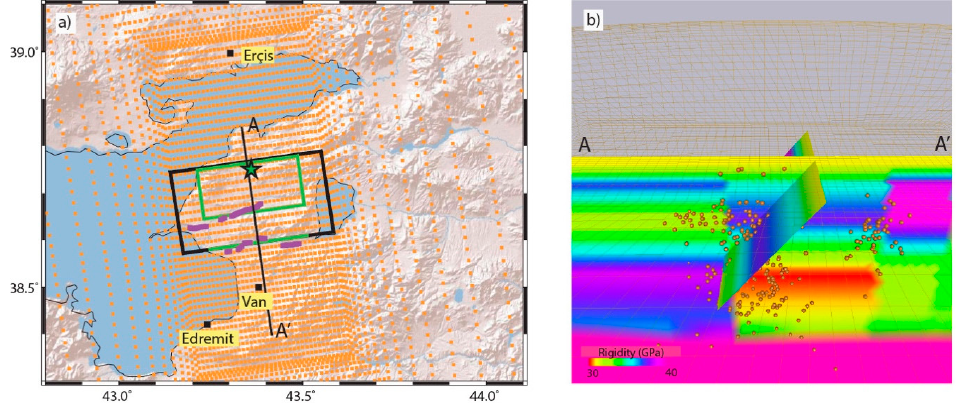
Figure 5. FE model of the Van Earthquake: ( a ) Top view of the model. The uniform slip fault is reported by green line while the fault plane used to retrieve the slip distribution is indicated by the black line. Surface ruptures constrained by InSAR are indicated by purple lines. The green star is the hypocenter and the orange dots are the surface nodes of the FE model; ( b ) Rigidity distribution on the section AA’ (see Figure 3) and on the fault plane within the heterogeneous FE model, view from West. The external edges of the FE model are shown with ochre lines. The seismicity within few kilometers from the section is reported by ochre spheres.